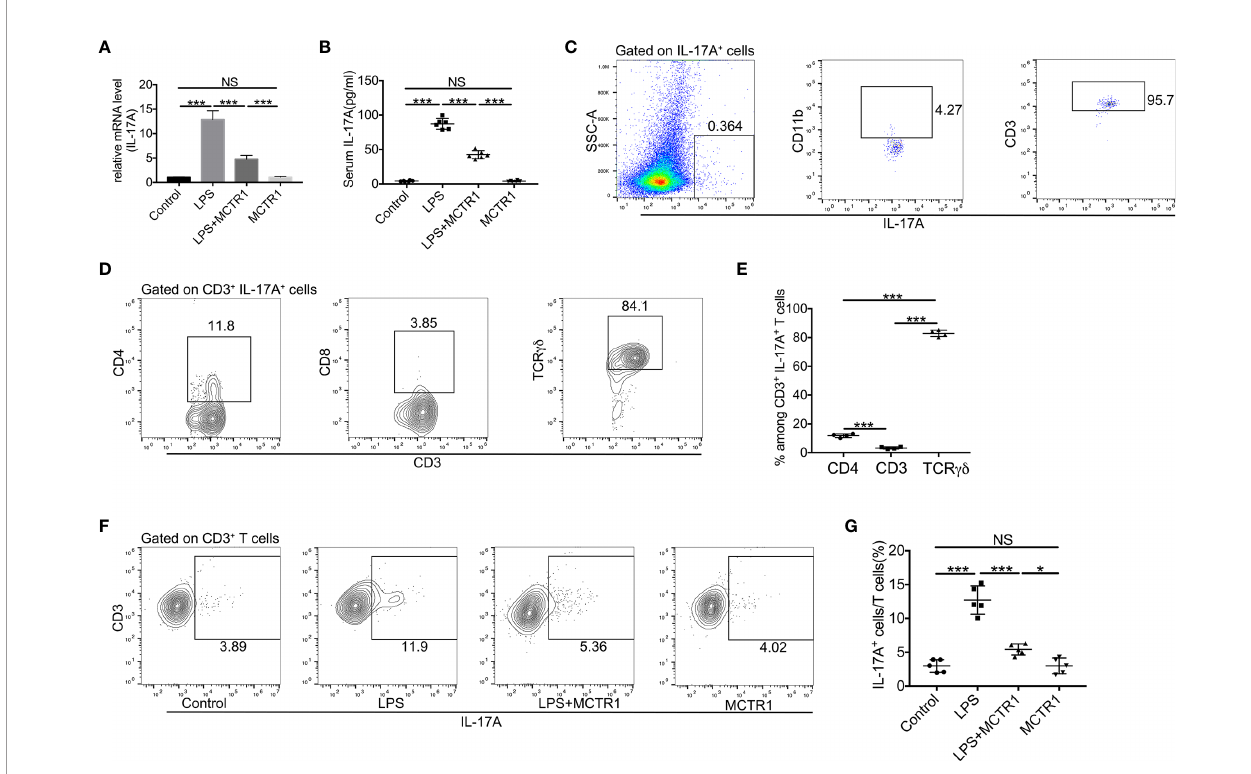
FIGURE 5 | MCTR1 attenuated IL-17A production and IL-17A + cells in LPS-induced cardiac injury. (A) The mRNA level of IL-17A in hearts was examined using quantitative PCR (n = 6). (B) IL-17A in serum was determined by ELISA (n = 6). (C) Flow cytometric analysis of CD11b and CD3 expressions on gated IL-17A + cells in the LPS-damaged hearts. (D, E) TCR gd , CD4, and CD8 expressions on gated CD3 + IL-17A + cells were examined by fl ow cytometric analysis in the LPS-damaged hearts (n = 4). (F, G) The percentage of IL-17A + cells in all CD3 + T cells was determined by fl ow cytometric analysis (n = 5). Data are shown as means ± SD. * P < 0.05; *** P < 0.001; NS, not signi fi